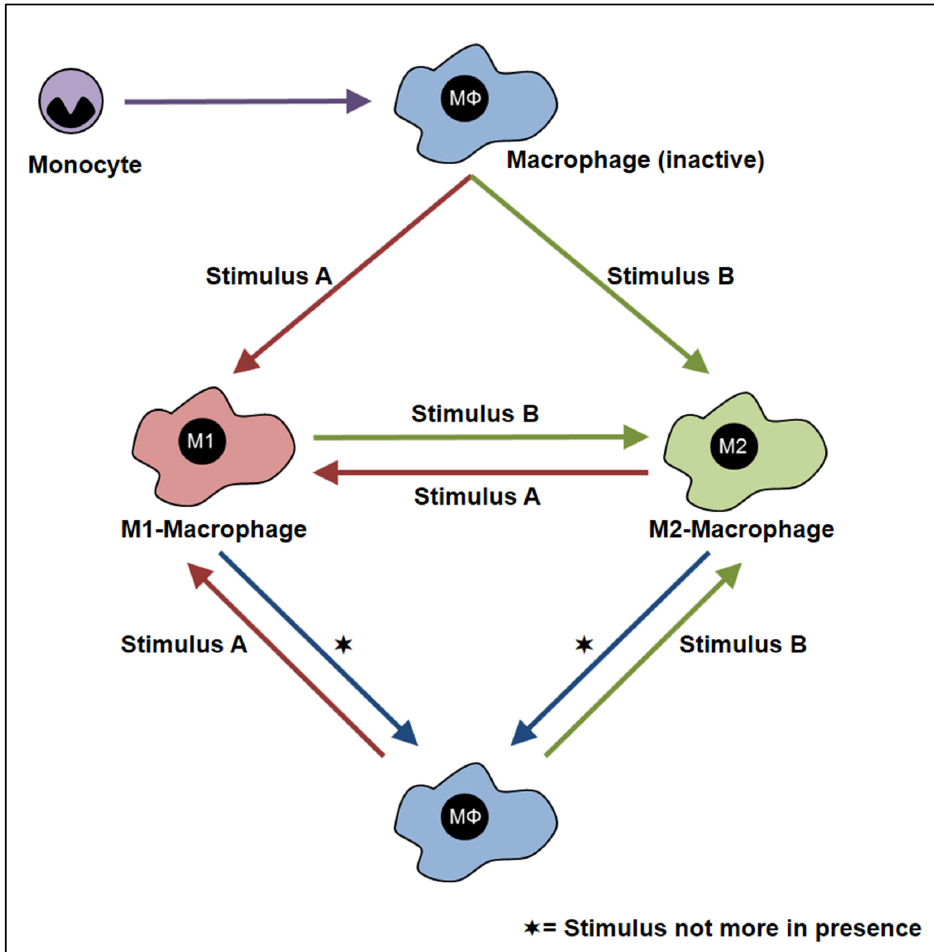
Figure 2. Plasticity of macrophages: a brief schematic depiction of the plasticity of macrophages from an inactive macrophage (M Φ ) into either an M1-macrophage or M2-macrophage according to different stimuli. The scheme represents macrophages as an activations state of cells that can be changed along a continuum into the different sub-populations according to various stimuli in the environment. In addition, M1 and M2 macrophages can be turned into inactivated macrophages if there is a lack of